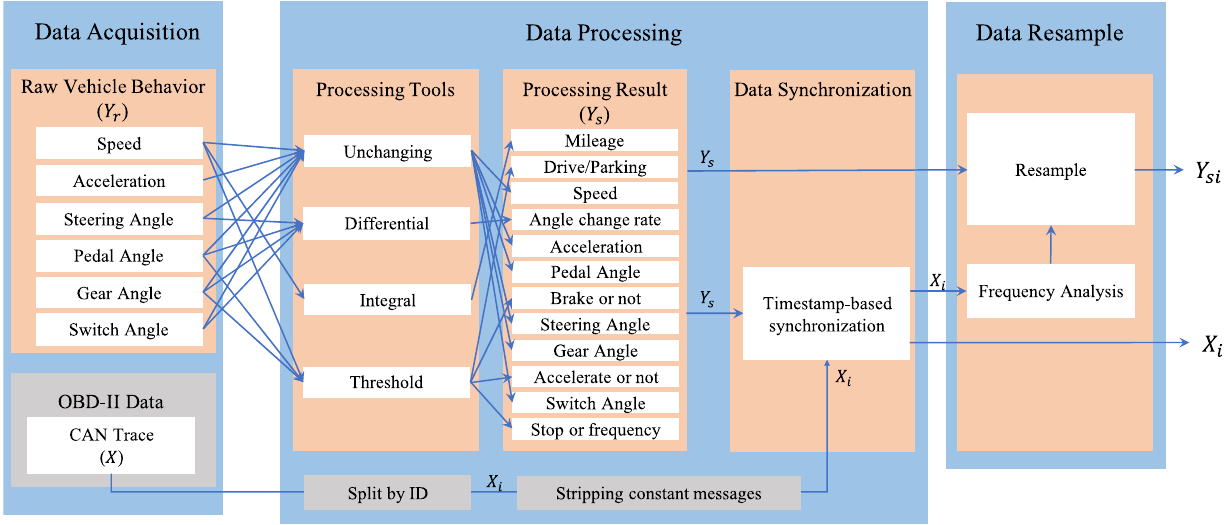
Figure 5. Data collection and processing flow.